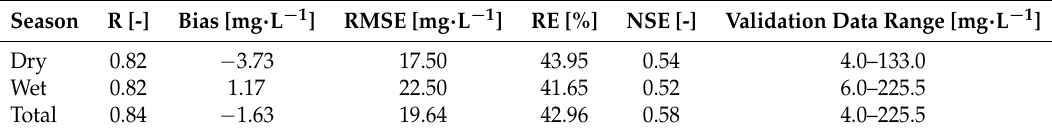
Table 1. Error statistics for validation of empirical model compared to the validation